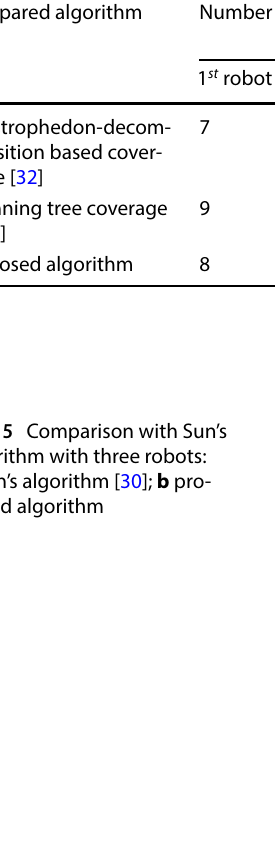
Table 11 Comparison of proposed algorithm with Nair’s algorithm [32] Compared algorithm